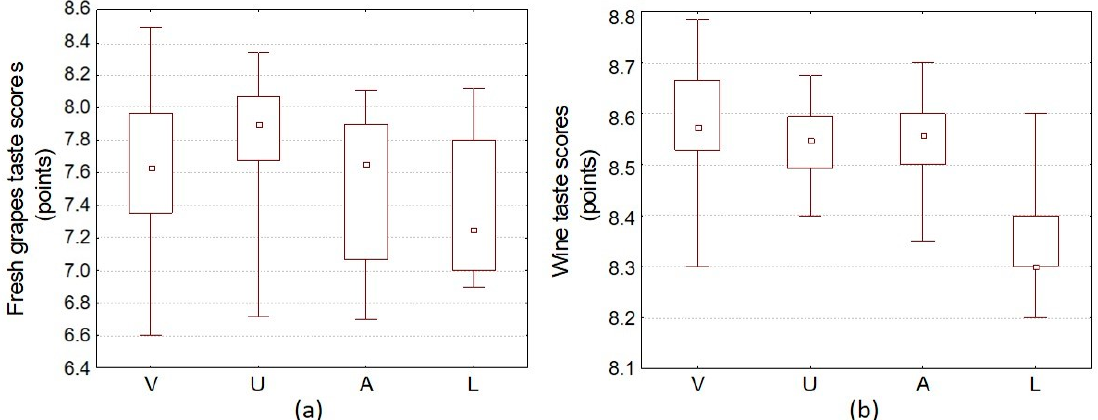
Figure 2. Taste scores for ( a ) fresh grapes, ( b ) wine for the groups of varieties of different interspecies origin. Median, lower, and upper quartiles, min-max are presented. Designations: V— V. vinifera , U—hybrids with several American species, A— V. vinifera × V. amurensis , L— V. vinifera × V. labrusca . The group of ripening did not have a significant effect on GS ( р = 0.332) or WS ( р = 0.784).